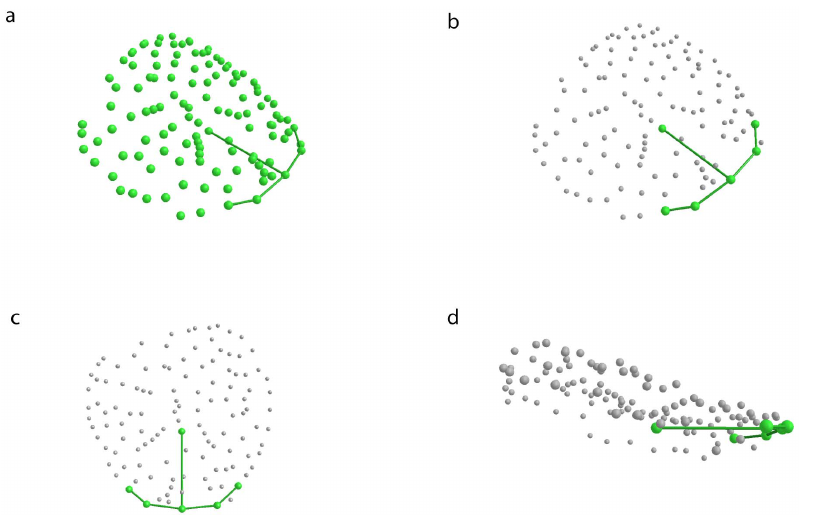
Figure 3. Orientation of the artificial swelling reconstructions. Coordinate data read into Morpheus et al. and plotted in 3D space. (a) All landmarks from photogrammetric reconstruction. (b) All but the first six anatomical landmarks demoted to secondary points. (c) Representation of alignment of the six anatomical landmarks to their spatial principal components (view of xy, i.e., PC1PC2, plane from above). (d) Representation of lateral view after alignment. Secondary points (gray) were used in the volume estimation based on their position (xy) and height (z) above the plane. Not all figures to the same scale. Symbol sizes, especially in (d) somewhat distorted due to plot perspective and magnification.